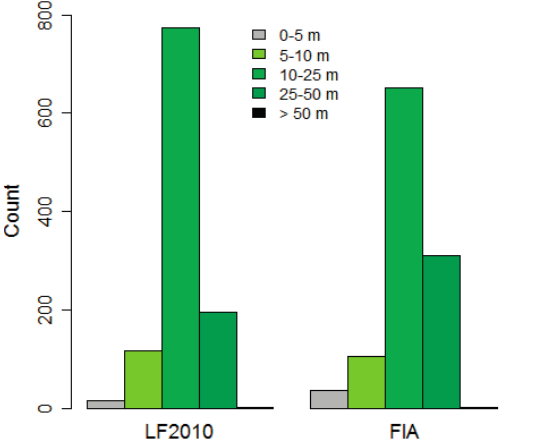
Figure 7. Histograms of binned FHC derived from the LF2010 mapped canopy height FIA field data